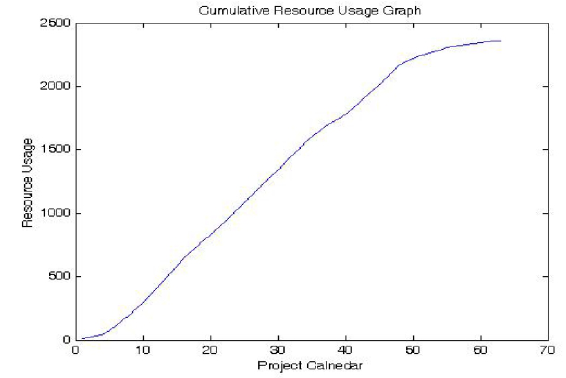
Figure 45. Cumulative resource usage for resource 1 of experiment 3 (after using forward method)